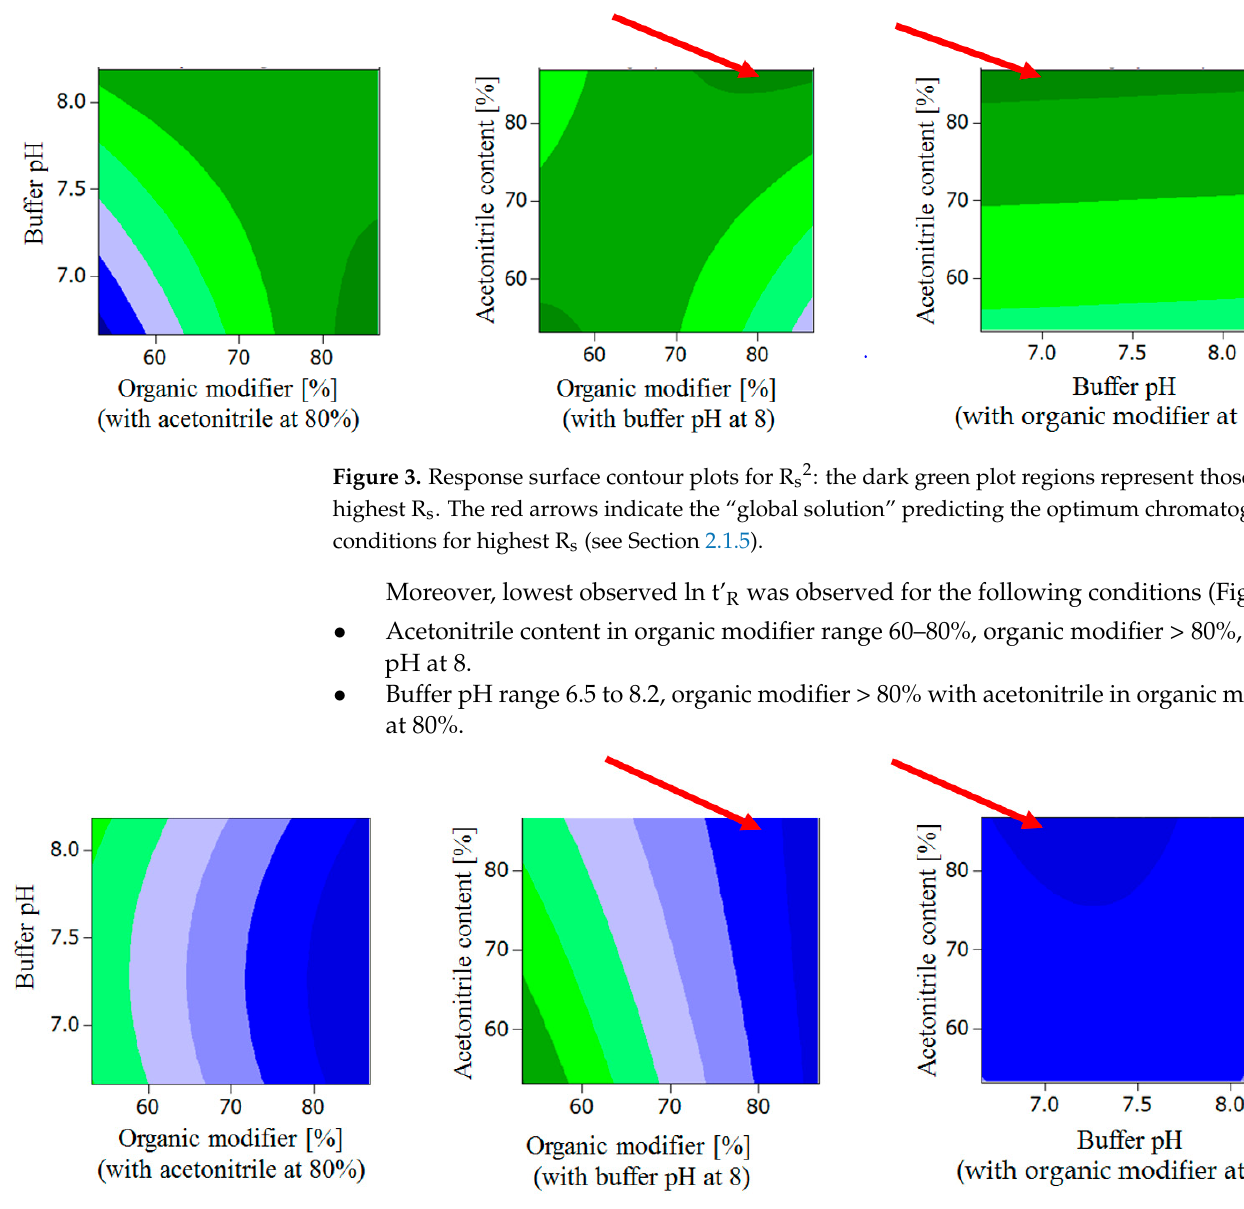
Figure 4. Response surface contour plots for ln t’ R : The dark blue plot regions represent those of the highest ln t’ R . The red arrows indicate the “global solution” predicting the optimum chromatographic conditions for lowest t’ R (see Section 2.1.5).